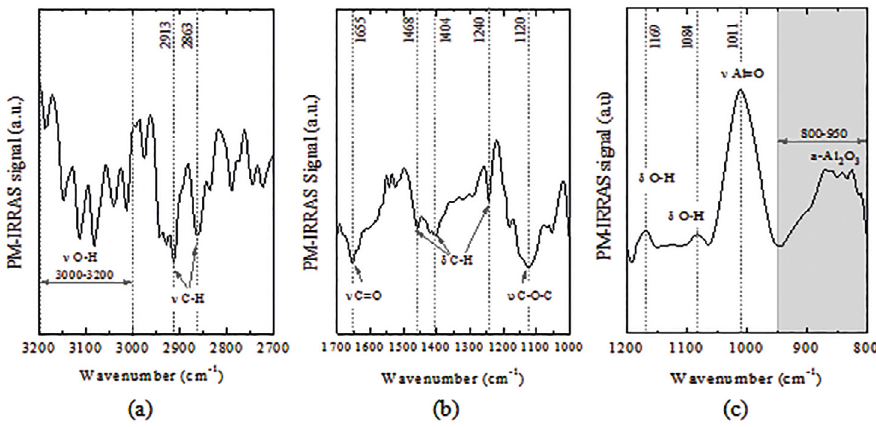
Figure 4. PM-IRRAS spectrum of the film deposited in the grounded holder, taken in the (a) 2700-3200 cm -1 , (b) 1000-1700 cm -1 and (c) 800-1200 cm -1 regions. Table 2. Wavenumber of the absorption bands present in the PM- IRRAS spectrum of the film deposited with no bias pulses. Wavenumber (cm - ¹)